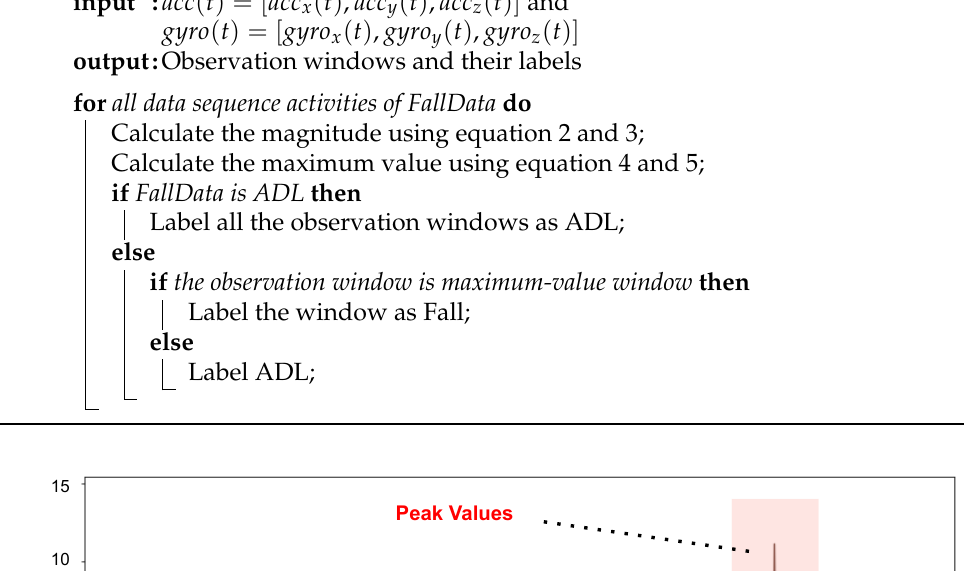
Algorithm 1 Calculating the maximum value and labeling the window